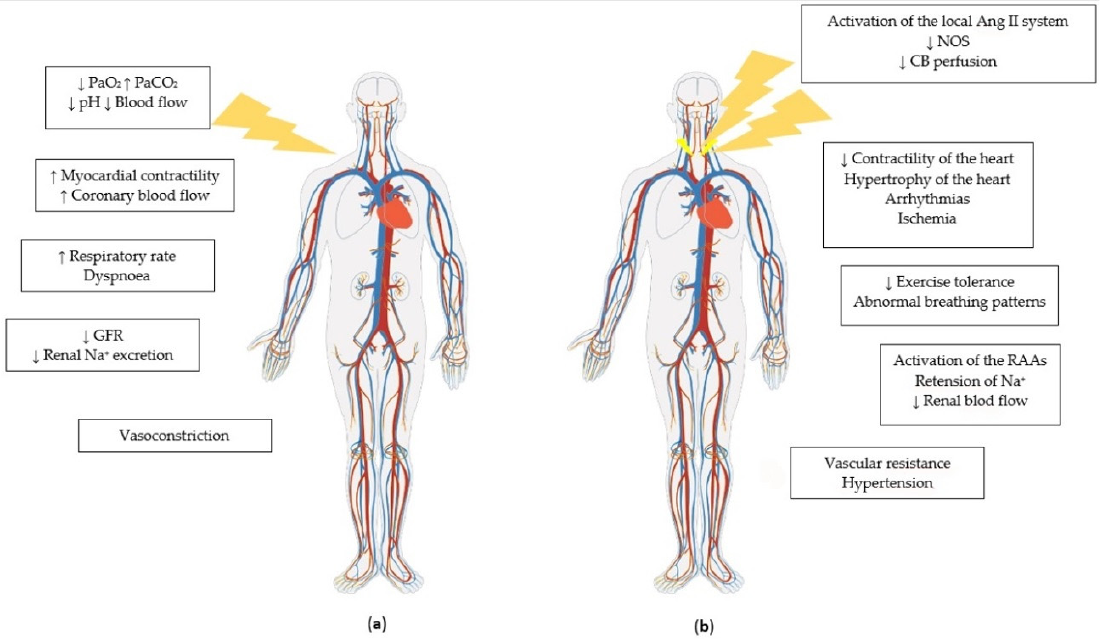
Figure 1. ( a ) Illustration of the triggers and organic effects of carotid body activation; and ( b ) Possible causesofcarotidbodyoveractivityanditsorganiccomplications. AngII—angiotensinII;CB—carotidbody; GFR—glomerular filtration rate; Na + —natrium ion; NOS—nitric oxide synthase; PaCO 2 —partial pressure of carbon dioxide; PaO 2 —partial pressure of oxygen; pH—potential of